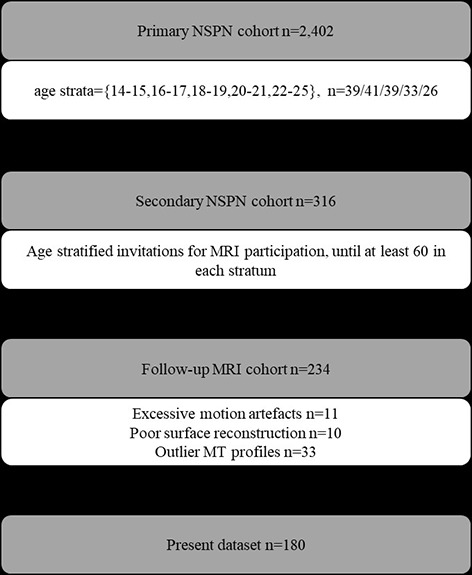
Sampling design.